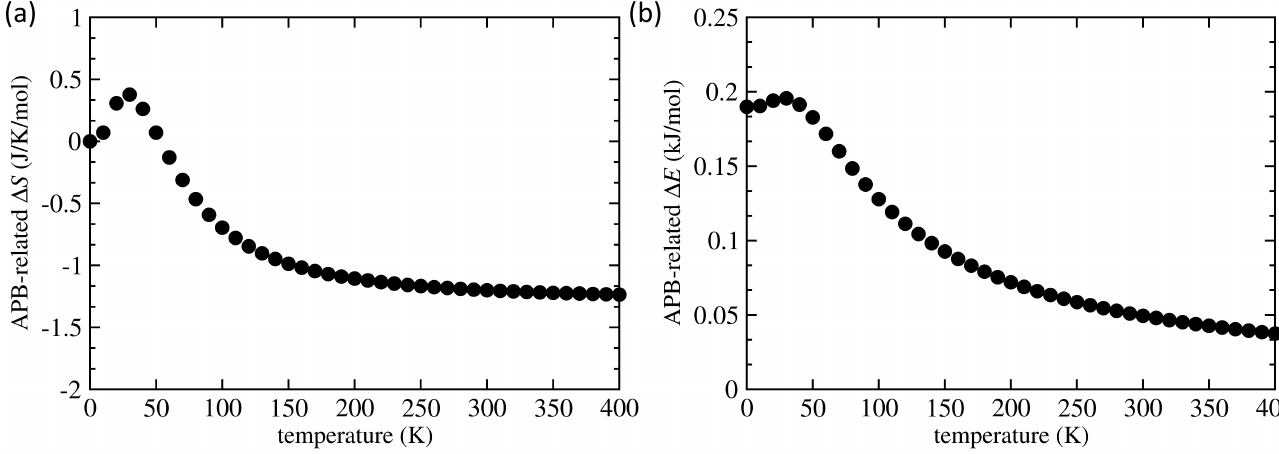
Figure 9. Computed entropy difference ∆ S ( a ) and phonon energy difference ∆ E ( b ) (both per 64-atom supercell) between (i) the states of Fe 3 Al with Cu but without APBs and (ii) with the Cu atoms at the APB